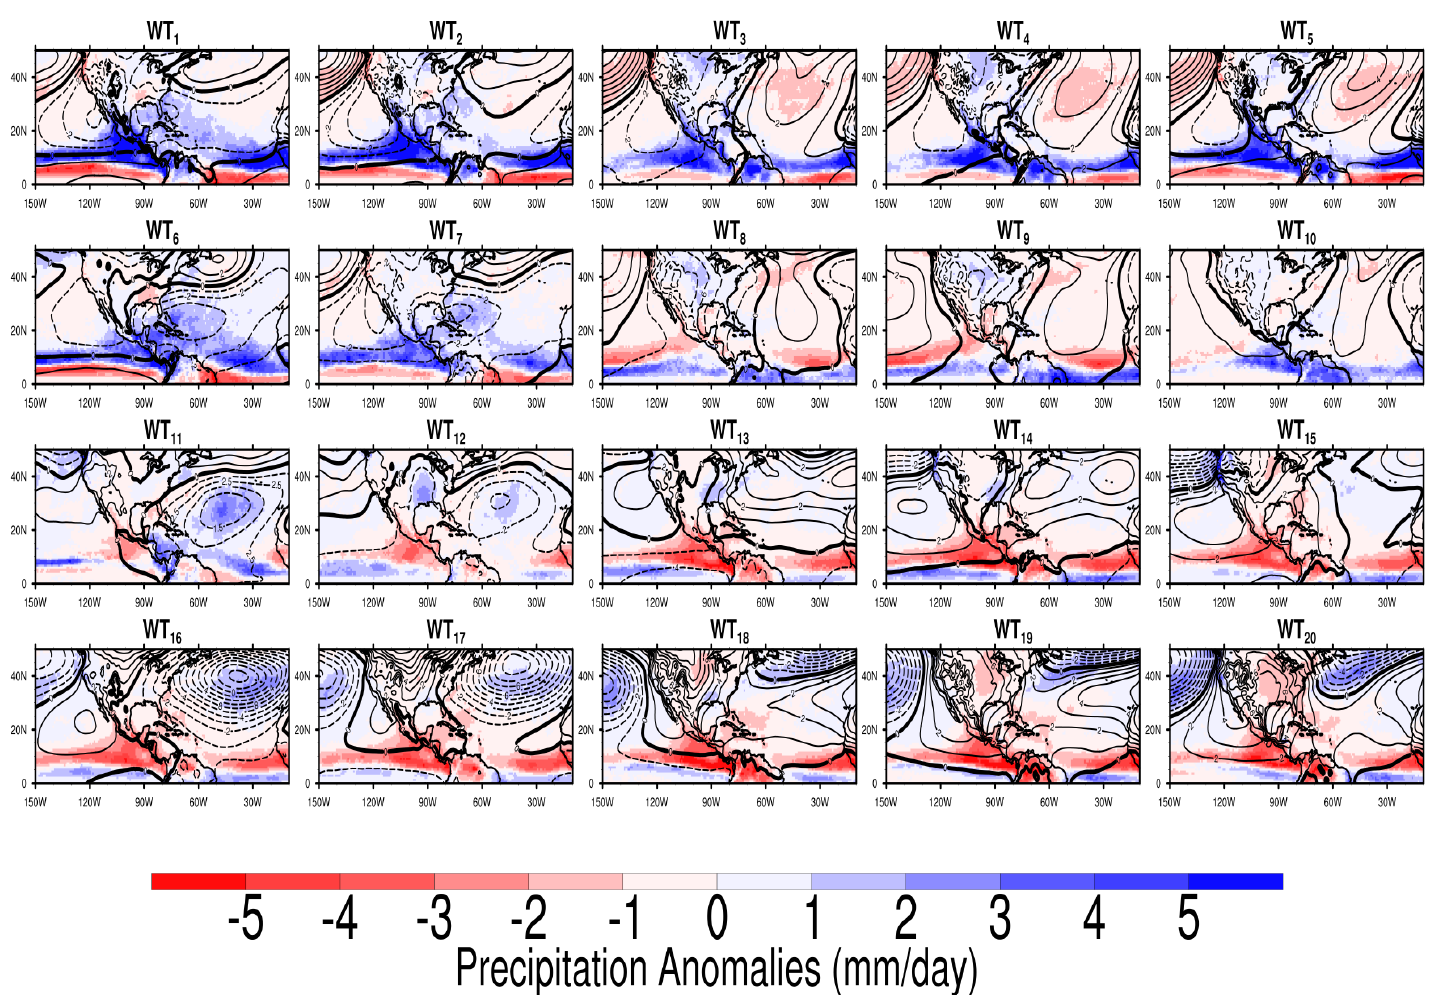
Figure 2. Composite averages of mean sea-level pressure anomaly (contours from − 16 to 13, by 1 hPa) and Climate Hazards InfraRed Precipitation (CHIRP) anomaly (colors) fields per SOM node. Continuous (dashed) contour lines represent positive (negative) anomalies; bold contour line is